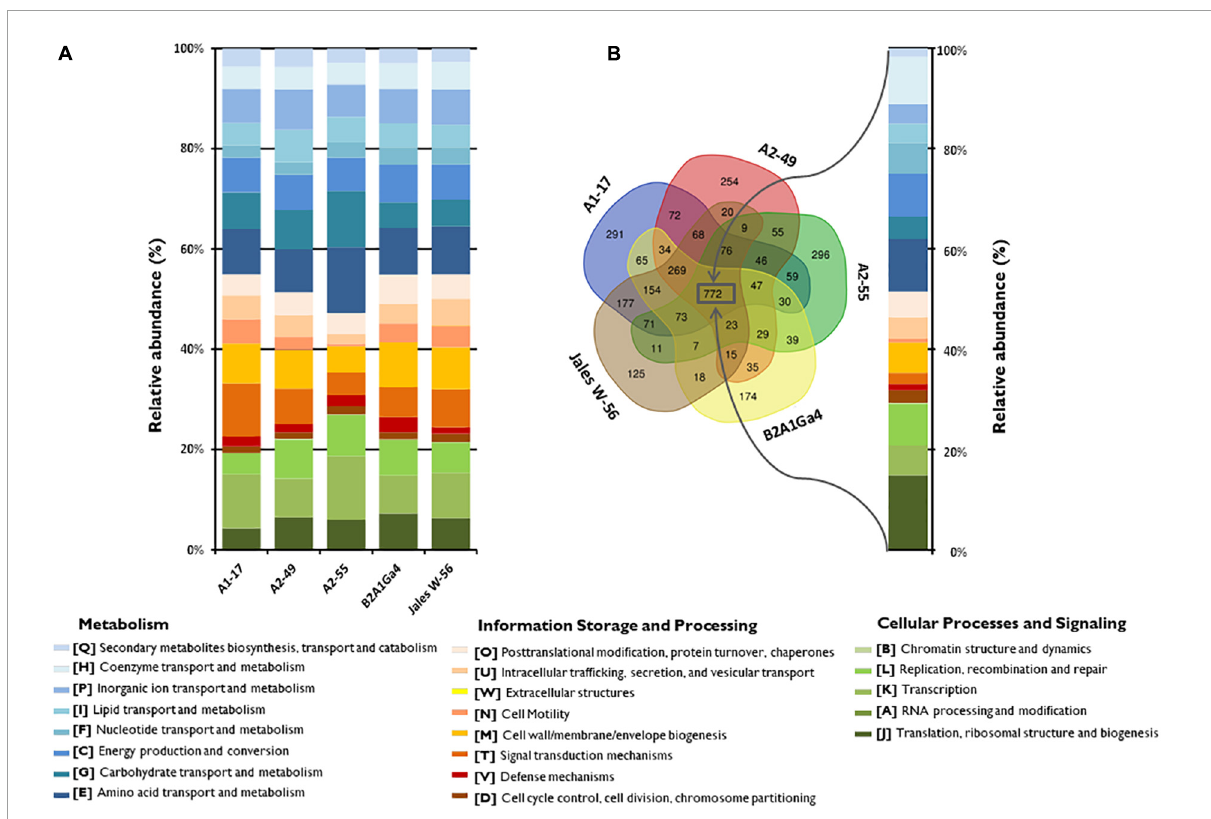
FIGURE1 Distribution and comparison of COG functional categories in the analyzed genomes. (A) Relative abundances (%) of the 21 different COG functional categories in each genome according to three broad functional groups (Metabolism; Information Storage and Processing; Cellular Processes and Signaling). (B) Venn diagram showing the shared and unique gene clusters (COGs) among the genomes and the relative abundances (%) of the shared COG